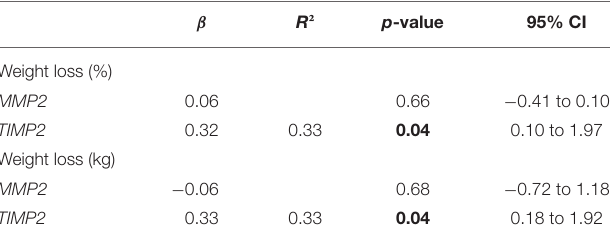
TABLE 2 | Linear regression analysis for matrix metalloproteinase-2 ( MMP2 ) and tissue inhibitor of metalloproteinases 2 ( TIMP2 ) expression with Study Group participants, after